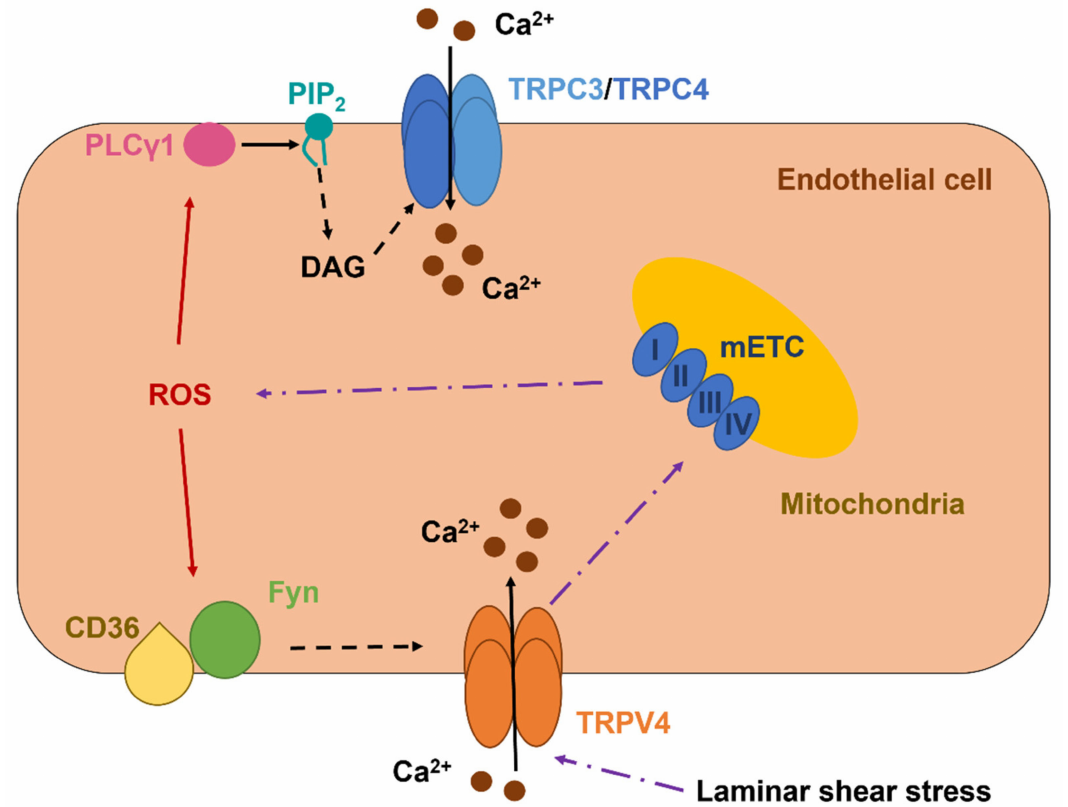
Figure 2. ROS activates TRPC3/TRPC4 heterotetramers and TRPV4 in vascular endothelial cells. ROS may activate endothelial TRPC3/TRPC4 heterotetramers and TRPV4 by exploiting two distinct mechanisms. ROS could stimulate PLC γ 1 to cleave DAG from the minor membrane phospholipide, PIP 2 , thereby gating the TRPC3/TRPC4 heterotetramer. ROS could be detected by Fyn, which is required to activate TRPV4 in a redox-sensitive manner. The physical association between Fyn and TRPV4 is maintained by CD36. Laminar shear stress may boost the mitochondrial production of ROS by stimulating TRPV4-mediated extracellular Ca 2+